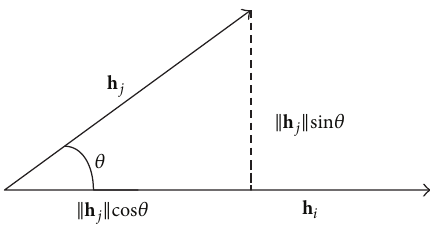
Figure 2: Interpretation of inner product between h 𝑗 and interpre- tation of resolution of h 𝑗 along h 𝑖 and perpendicular to h 𝑖